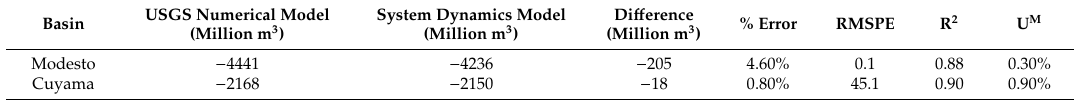
Table 6. Comparison of results for the 1-year simulation.